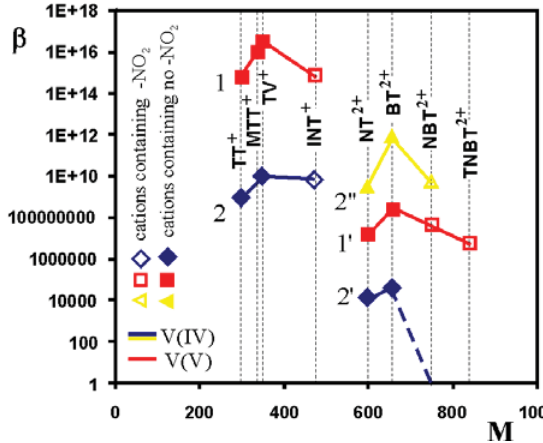
Figure 5. Association constant ( β ) of tetrazolium ion-associated complexes vs. molecular mass of tetrazolium cation (M) plots for the ion associates with: [VO (PAR) ] 3- (lines 2 2 1 and 1’ [32,34]), [VO(PAR) ] 2- (lines 2 [30] and 2’) 2 and [VO(OH) (PAR) ] 4- (line 2”). TT + - 2,3,5-triphenyl- 2 2 2H-tetrazolium, MTT + -